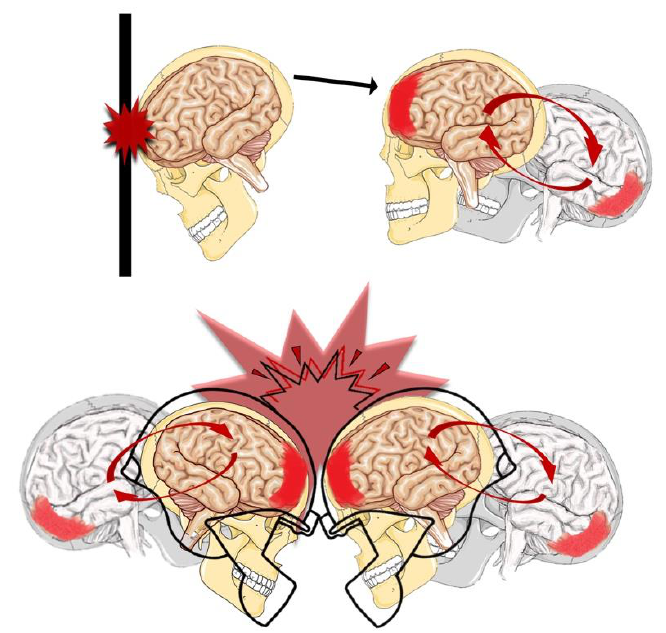
Figure 1. Concussion or traumatic brain injury (TBI) may alter brain functions. Concussion or traumatic brain injury could change the way the brain functions. This can lead to bruising and swelling of the brain, tearing of the blood vessels and injury to nerves, causing the concussion. The brain is made up of soft tissue and is protected by blood and spinal fluid. When the skull is jolted too fast or is impacted by something, the brain shifts and hits against the skull. Most concussions are mild and can be treated with appropriate care. However, left untreated, they can be deadly. The figure was designed by hand made as previously done in our studies [51,52].